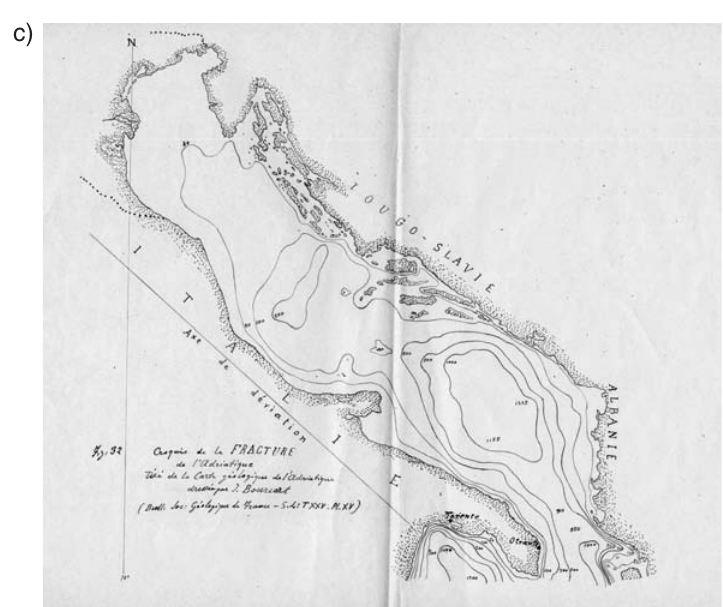
Fig. 8a-c. Some hand-drawn maps from the unpublished manuscript ‘dilatation planetaire’ of 1932. a) geomet- rical considerations of Mantovani about the conformity between the coast of Brazil and the Guinea Gulf. The opinion of the Italian was that the non perfect coincidence of the coasts in his fig. 23 shows that the African con- tinent has undergone a deformation, a «deviation towards east of the coast». This problem is know as the Jef- freys objection against the continental drift, and was resolved by Samuel Warren Carey using shiftable transpar- ent spherical caps on a wooden globe to displace the continents on the sphere avoiding the cartographical dis- tortions (Scalera, 2003). b) Outline of the evolution of the Indian Ocean. The arrows indicate the «general devi- ation and translation toward East of the three peninsulas: Arabia, India and Indochina». c) The Adriatic sea basin was judged by Mantovani as an incipient fracture of the Earth crust. The map was drawn on the base of the Geo- logic Map of the Adriatic by Jacques Bourcart, the scientist that in 1924 pointed out the work of the Italian to Alfred